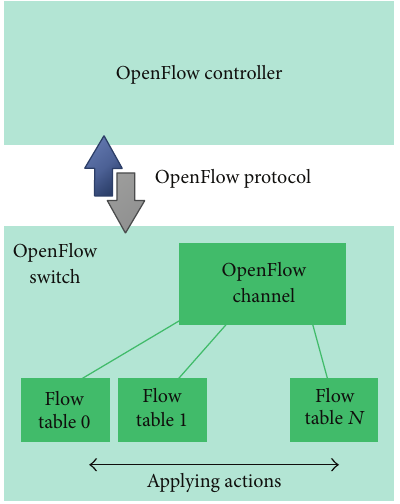
Figure 1: SDN architecture. Figure 2: OpenFlow